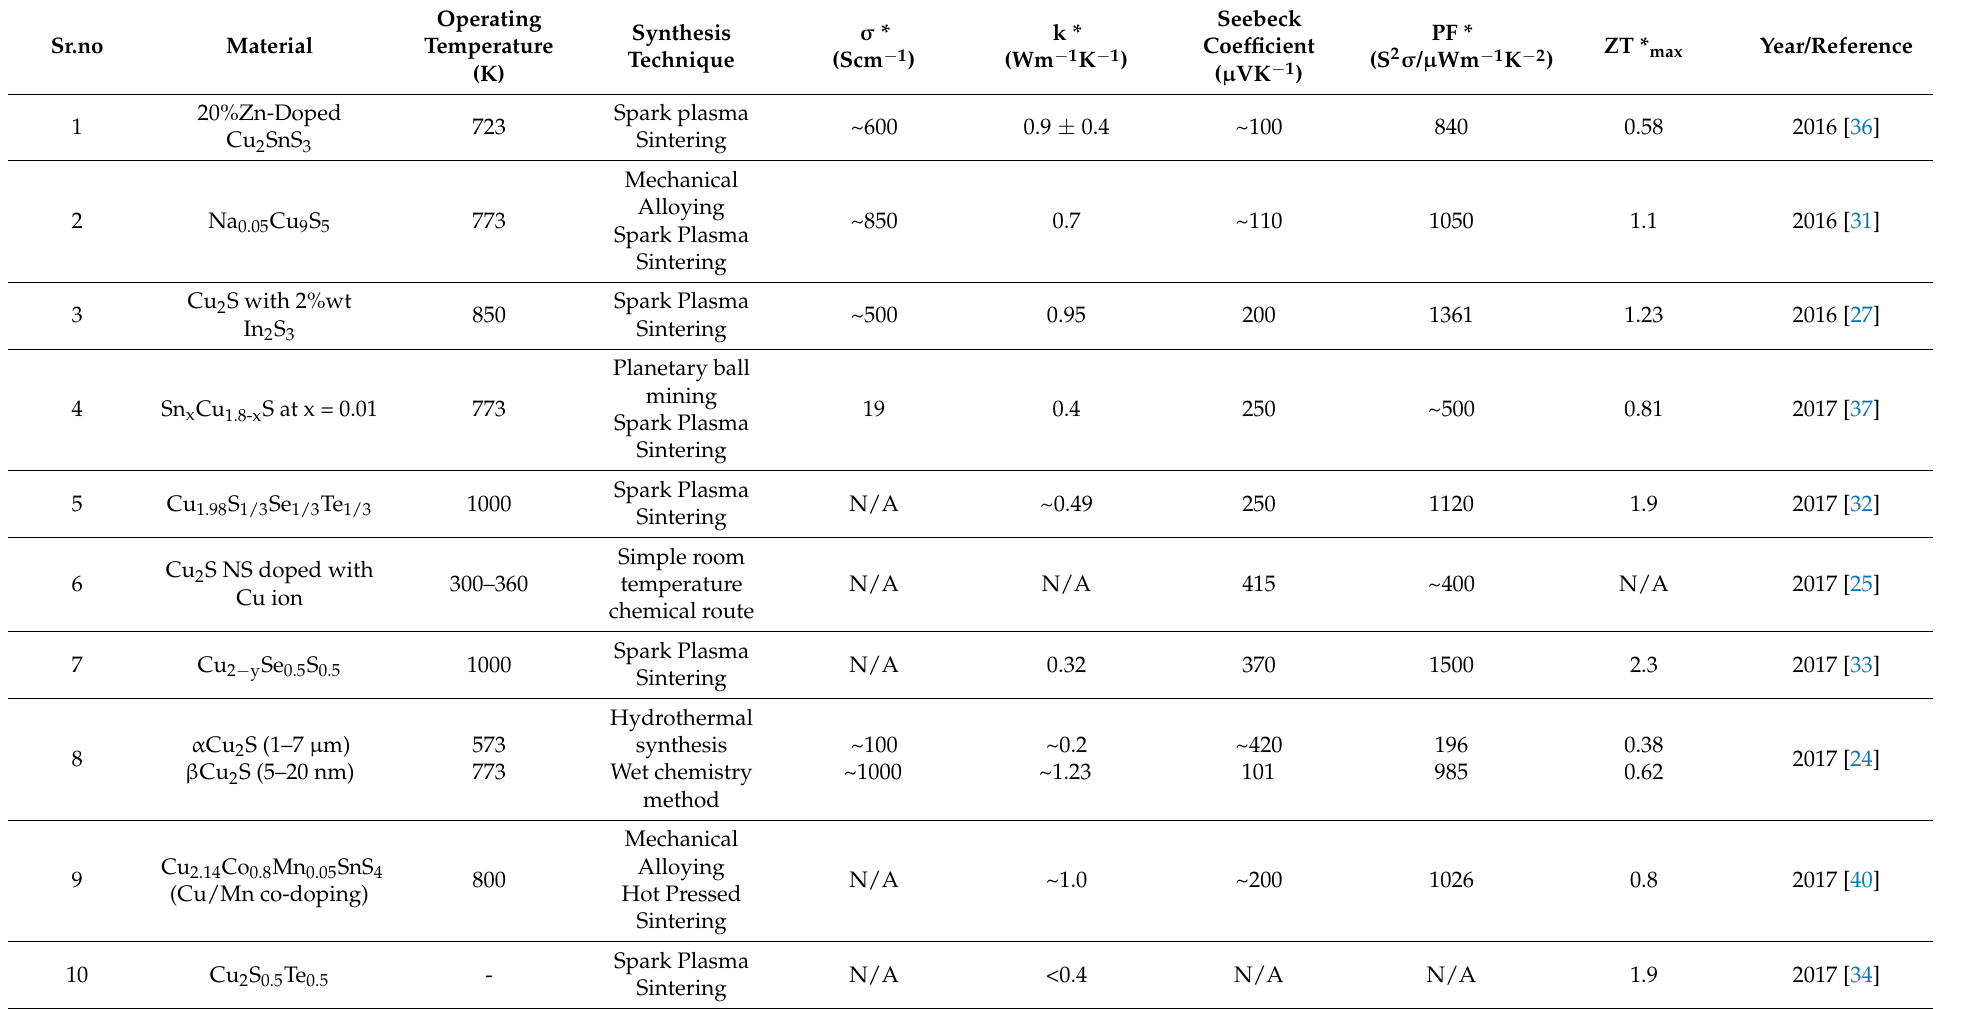
Table 2. Prominent copper-sulfide nanostructured alloys/composites reported from